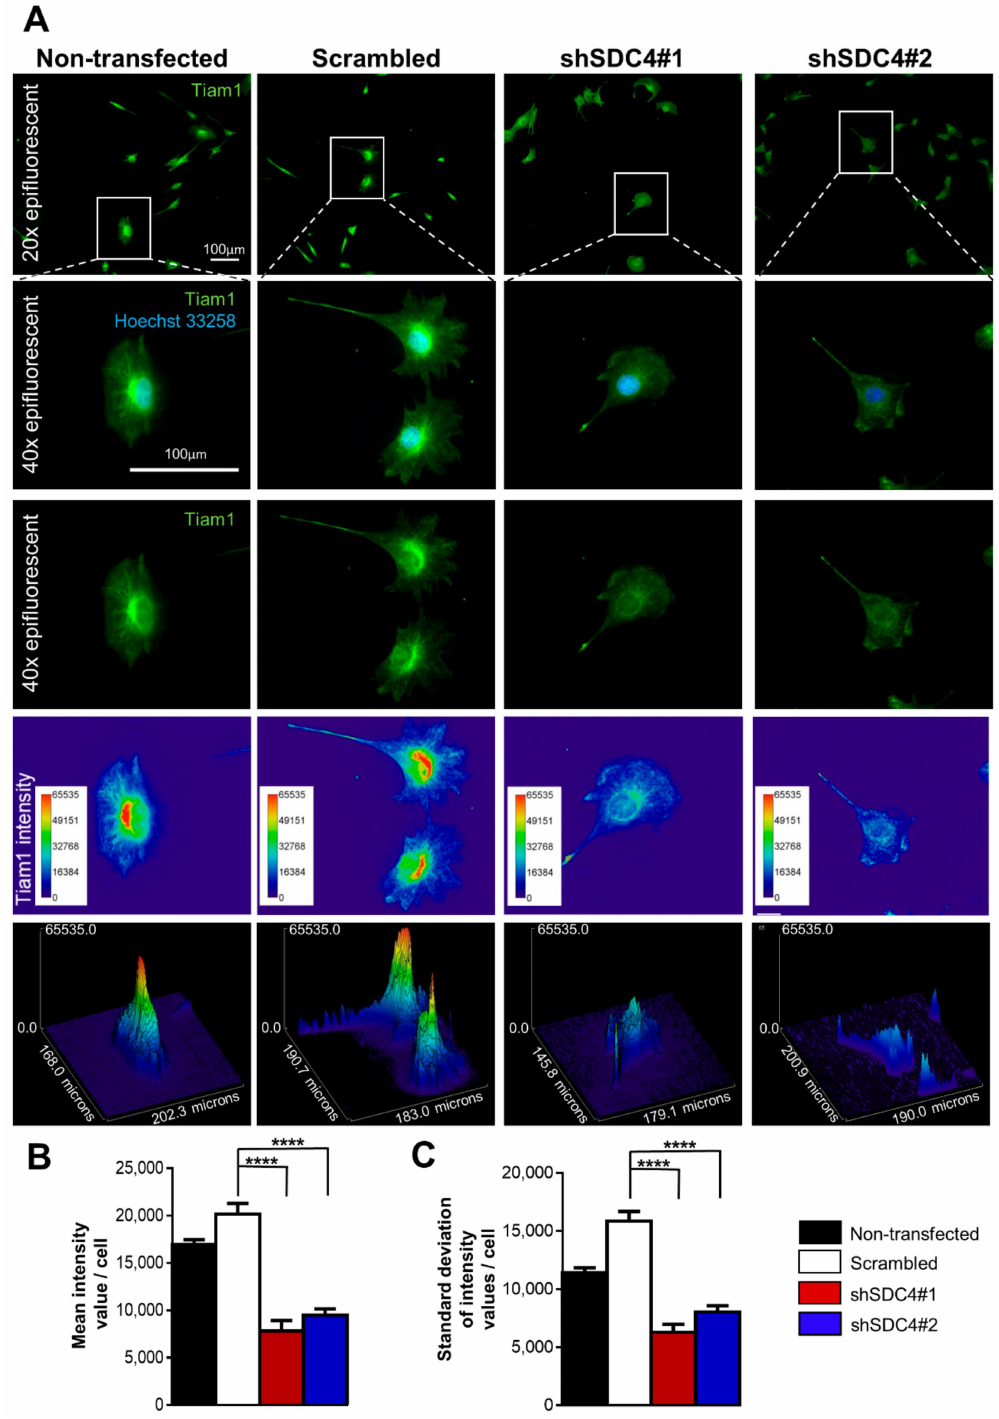
Figure 4. Tiam1 (T-lymphoma invasion and metastasis-1) expression of the di ff erent cell lines. ( A ) Representative images show Tiam1 (green) distribution. The non-transfected and scrambled cells exhibit an asymmetric, polarized Tiam1 arrangement, which is absent due to SDC4 silencing. Nuclei are blue (Hoechst 33258). Representative pseudocolor images (2D and 3D) depict Tiam1 signal intensity. The color was assigned to each pixel based on the pixel intensity value according to the calibration bar (shown on left-hand sides of the images). The mean intensity values in the individual cells are quantified in ( B ), and the average standard deviation values of the Tiam1 intensities are depicted in ( C ); n = 4–20 cells / cell line were analyzed; data are reported as mean + SEM; **** p <